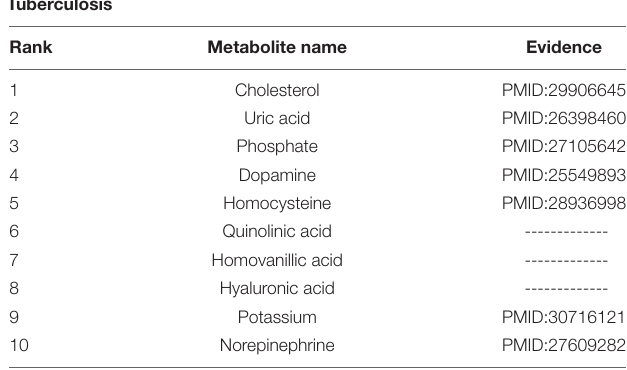
TABLE 2 | Candidate metabolites of tuberculosis.